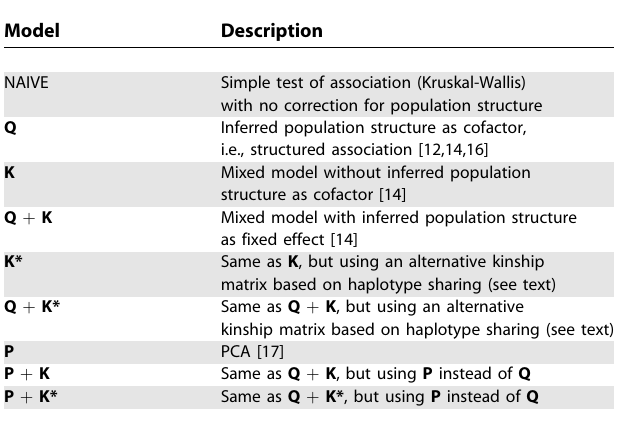
Table 2. Summary of Models